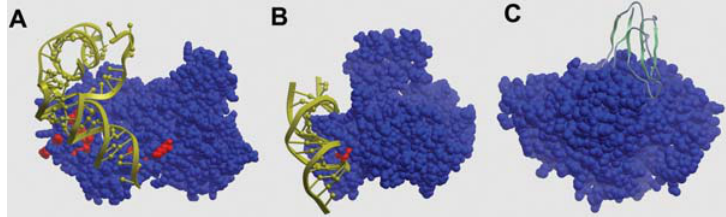
Figure 1 Identification of RNA-binding proteins by computer predictions. Protein residues predicted by the OPRA predictor on the unbound protein are colored in red, indicating an RNA-binding signal. For comparison purposes, the position of the interacting molecule in the reference complex structure is also shown. (A) The RNA-binding residues predicted in the unbound archaeosine tRNA-guanine transglycolase (PDB 1IQ8) are correctly located in the RNA-binding interface (PDB 1J2B). (B) A small RNA-binding signal identified in the unbound catabolite gene activator protein (PDB 1I5Z) is found in the DNA- binding interface (PDB 1BER), which shows the difficulty to discriminate DNA-binding proteins from RBPs. (C) There is no RNA-binding signal in the unbound acetylcholinesterase (PDB 1J06), which can bind other proteins (PDB 1MAH) but it is not known to bind nucleic acids. This exemplifies the possibility of using the OPRA predictor to distinguish between RBPs and protein-binding